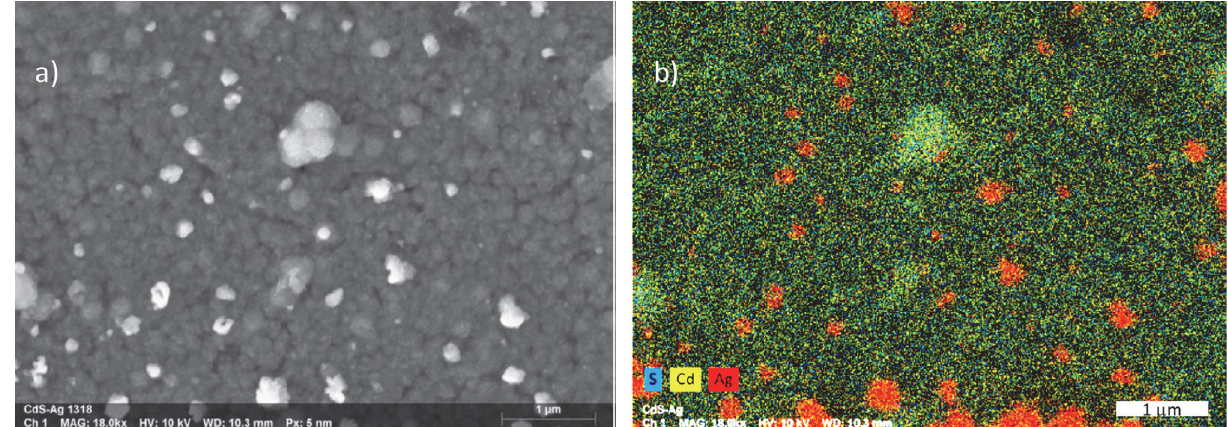
Figure 5. Silver coated thin film images: a) SEM 1μm at a magnification of 18,000×, b) EDS coupled to SEM surface